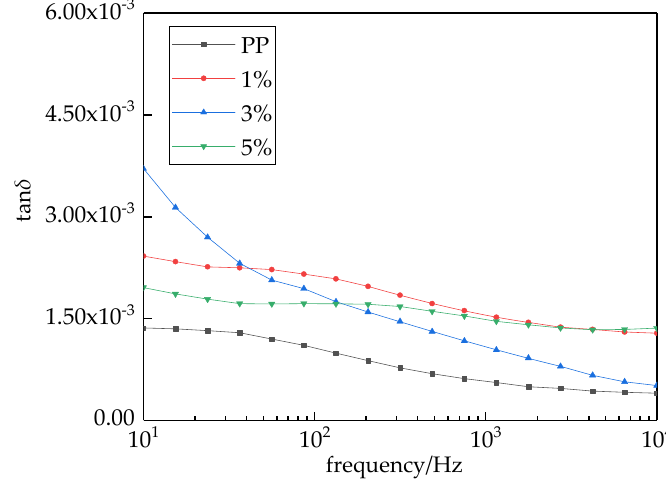
Figure 7. Frequency dependences of dissipation factor of MgO/PP composite.